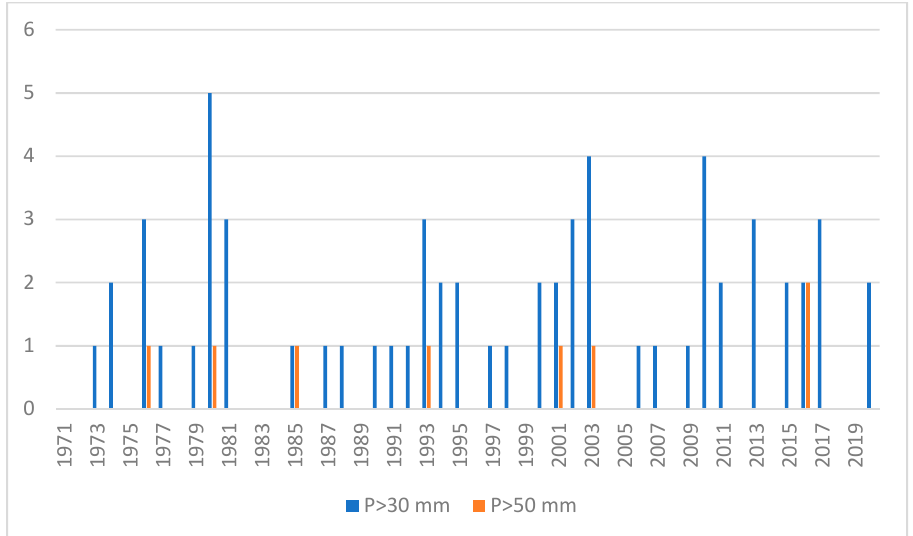
Figure 7. The number of days with daily precipitation (P) over 30 and 50 mm recorded at the meteorological station in Toru´n.